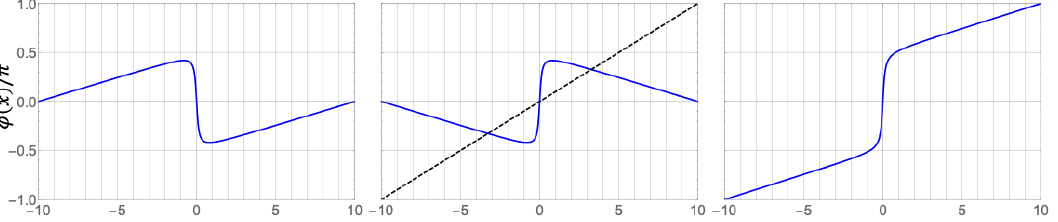
Figure 17. Phase profiles of the elliptic soliton solution of Equation (53). For J = 0, W < 0 and hence v > 0 (in the leftmost panel); for J = 0, W > 0 and hence v < 0 (in the middle panel); for J = 1 and W > 0 (in the rightmost panel). The black broken line 2 π x illustrates the first term of the phase profile L in Equation (59), which is also contained in Equation